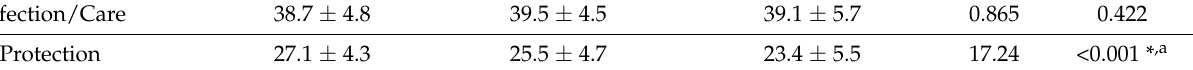
Table 5 demonstrates the logistic regression model of factors associated with psychi- atric morbidity (defined by CHQ) among the caregivers of youths who received COVID-19 vaccination. The multivariate model and stepwise regression model showed consistent results. The intrusion scores of IES (aOR = 1.10, p = 0.015) and protection of PBI (aOR = 1.08, p < 0.001) were significant factors associated with the psychiatric morbidity of